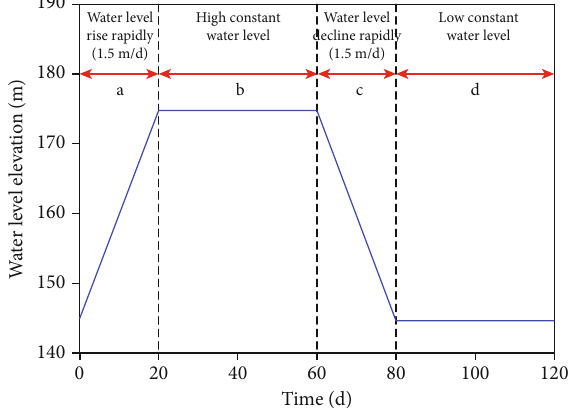
Figure 5: Fluctuation conditions of reservoir water level in di ff erent stages, respectively.